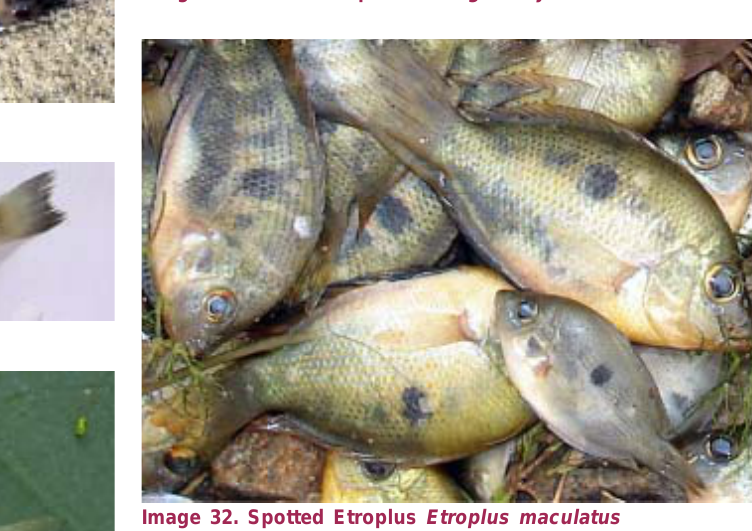
Image 32. Spotted Etroplus Etroplus maculatus